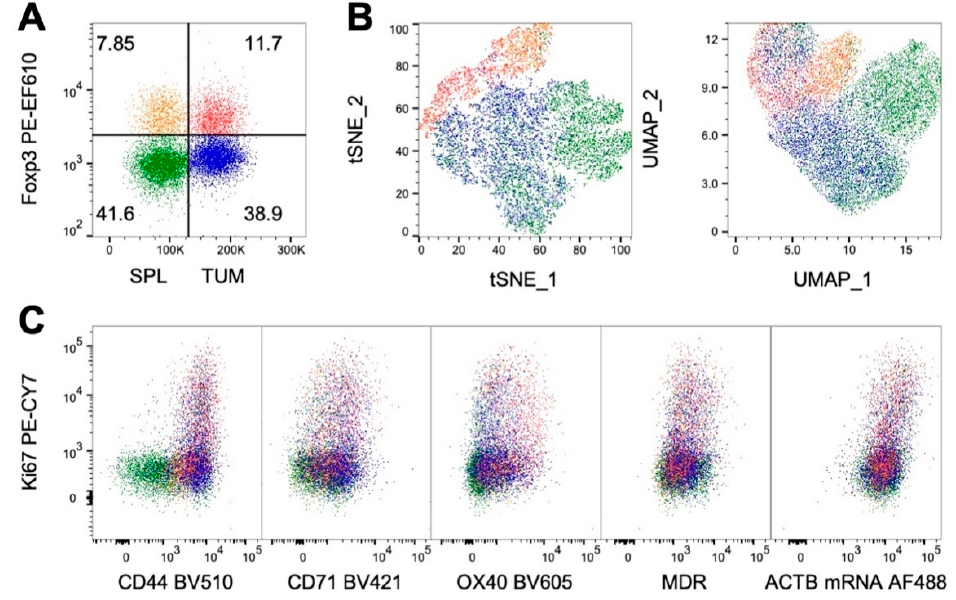
Figure 4. Unsupervised clustering analysis of flow cytometry data obtained from Tregs and Tconvs from spleen (SPL) or tumors (TUM). Gated CD4 T cells were downsampled and concatenated together and Tregs and Tconvs in both samples were manually identified according to Foxp3 expression. ( A ) Plot showing the overlay of gated Tregs and Tconvs in concatenated CD4 T cells from SPL and TUM. ( B ) tSNE (left) and UMAP (right) visualization of the distribution of Treg and Tconv populations from SPL and TUM in the concatenated samples according to the expression of markers indicated in Figure 3. Both multidimensionality reduction analyses were run with default settings in Flowjo 10.5.3. ( C ) Representation of the co-expression of Ki67 with the other markers in overlayed Treg and Tconv subsets in concatenated CD4 T cells from SPL e TUM sam- ples.